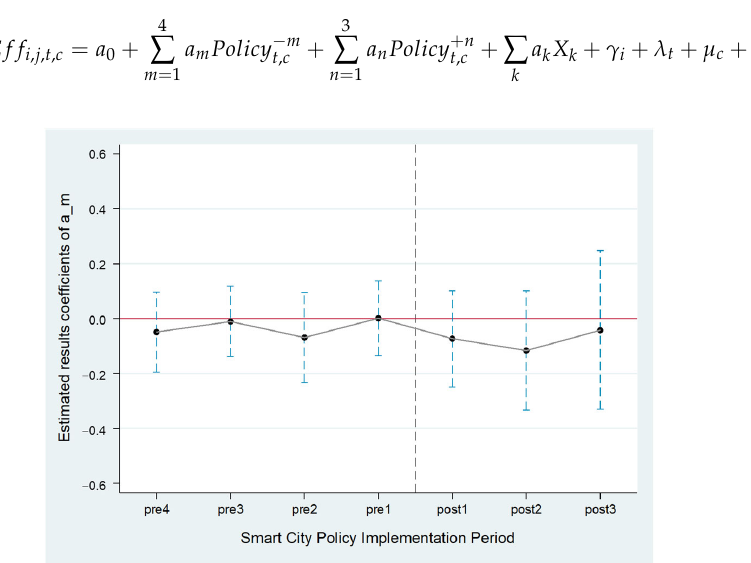
Figure 2. Result of the parallel trend test. a m is the difference in carbon emission intensity between the treatment and control groups before the policy (i.e., SCP) happens. The blue dashed line is the 95% confidence interval of the estimated a m . The red line marked the zero value of the estimated a m . The black dashed line connects the estimates in different periods.